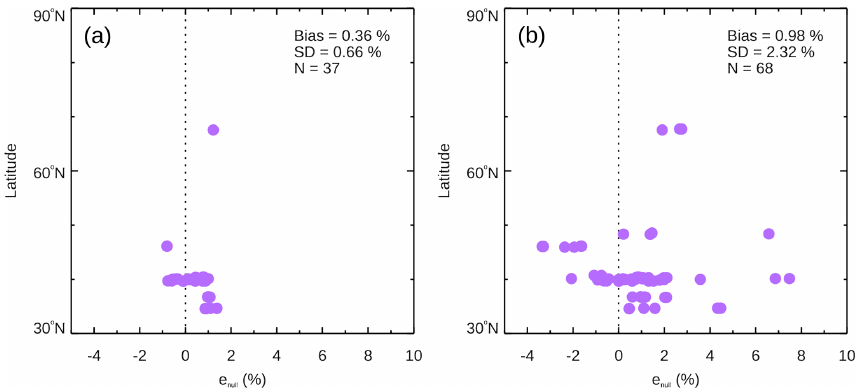
Figure 7. Latitudinal distribution of null-space error between TROPOMI and AirCore observations over land. (a) For clear observations. (b) For cloudy